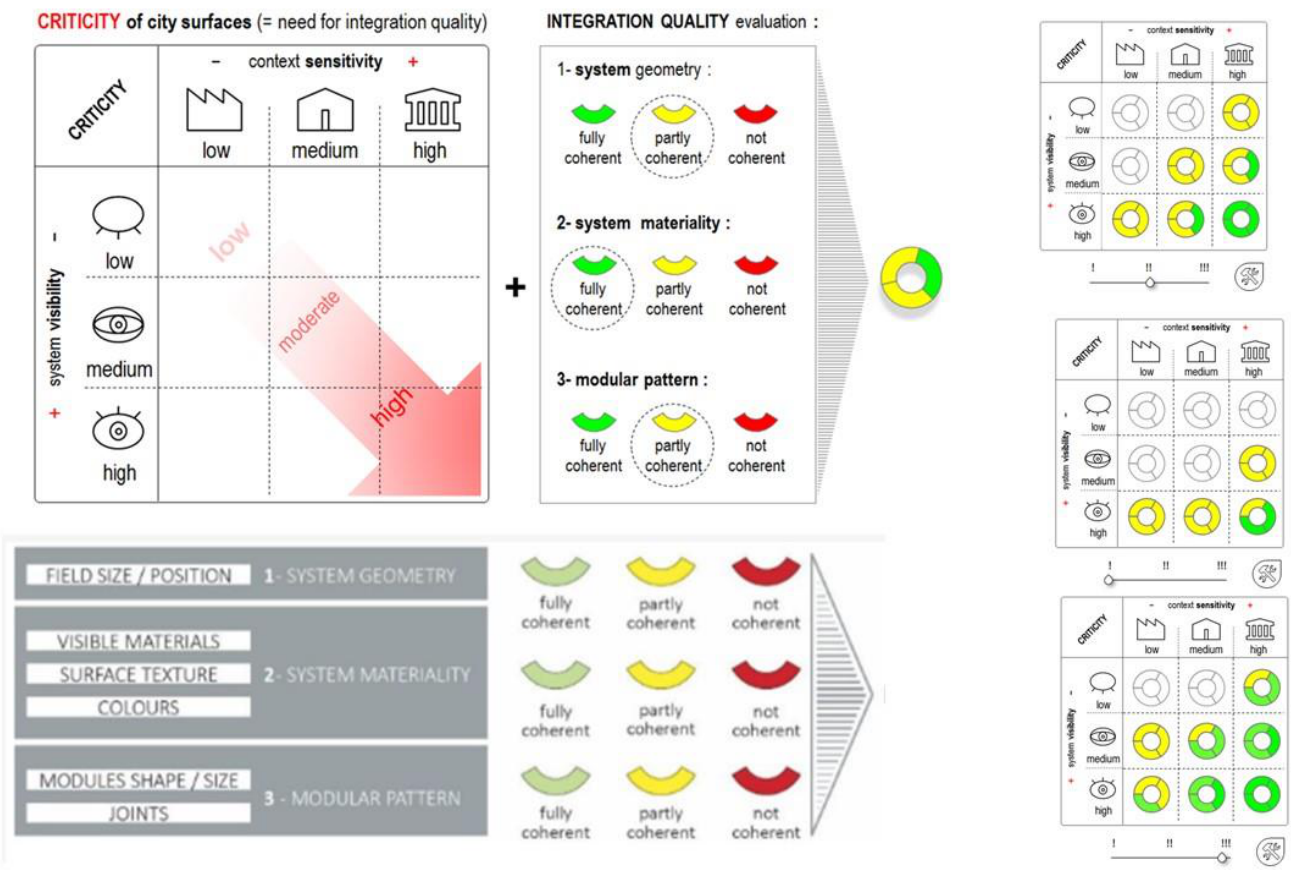
Figure 5. “ Criticity map ” considering visibility and sensitivity (Source: Authors’ elaboration from Figure 5. “Criticity map” considering visibility and sensitivity (Source: Authors’ elaboration from LESO-QSV — Architectural integration tool, https://www.epfl.ch/labs/leso/research/domains/re- LESO-QSV—Architectural integration tool, https://www.epfl.ch/labs/leso/research/domains/ newables_integration/leso-qsv, accessed on 14 February 2023). renewables_integration/leso-qsv, accessed on 14 February